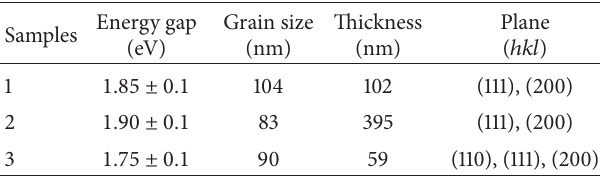
Figure 1: The XRD patterns of cuprous oxide thin films with different additives. Table 1: The energy gap, grain size, thickness, and plane ( ℎ𝑘𝑙 ) of the O Cu 2